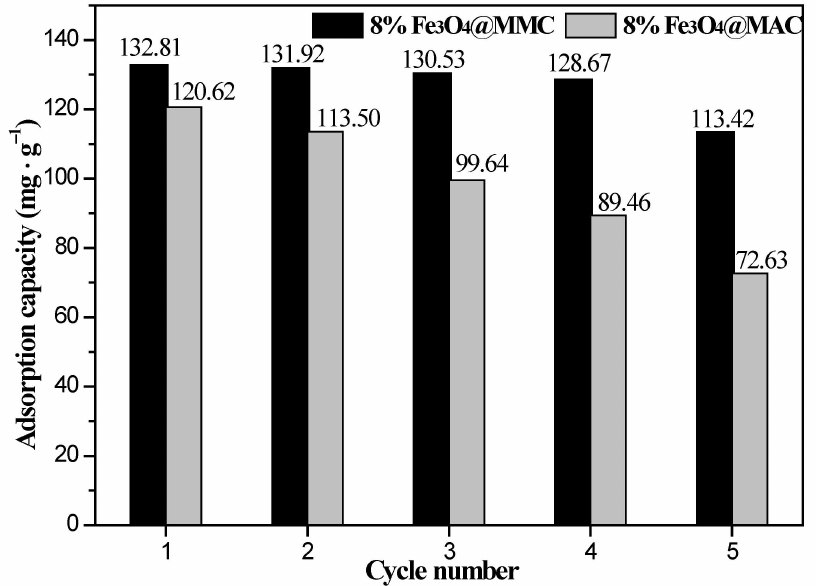
Figure 14. Repeated use of the 8%Fe 3 O 4 @MMC and 8%Fe 3 O 4 @MAC adsorbents. Adsorption conditions: the initial Cr(VI) ions’ concentration, 80 mg · L − 1 ; volume, 50 mL; pH, 2.0; adsorbent dosage, 0.03 g; temperature, 298 K; adsorption time, 180